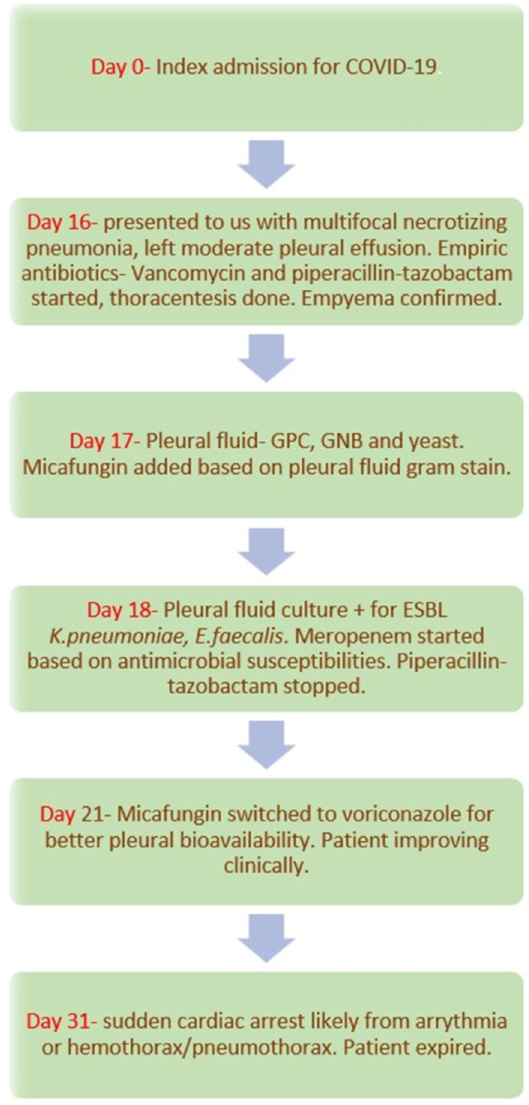
Figure 2. Timeline of patient’s clinical